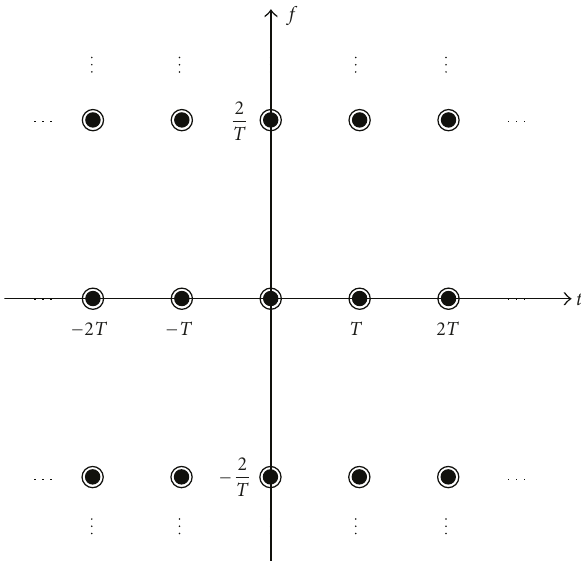
Figure 9: Time-frequency phase space for transmission in an FBMC system with QAM